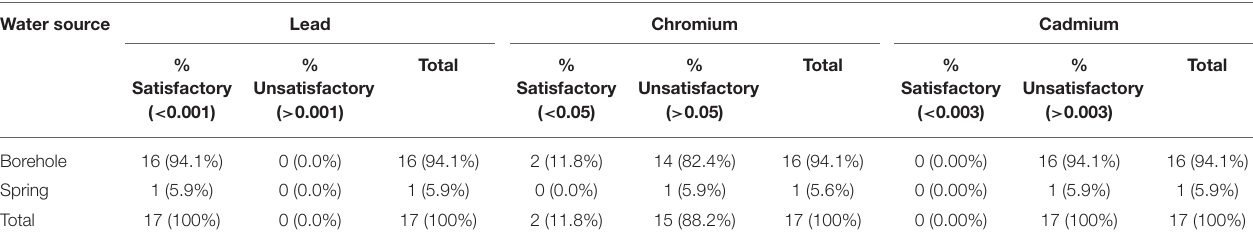
TABLE 3 | Concentrations of lead, chromium, and cadmium in packaged water. Water source